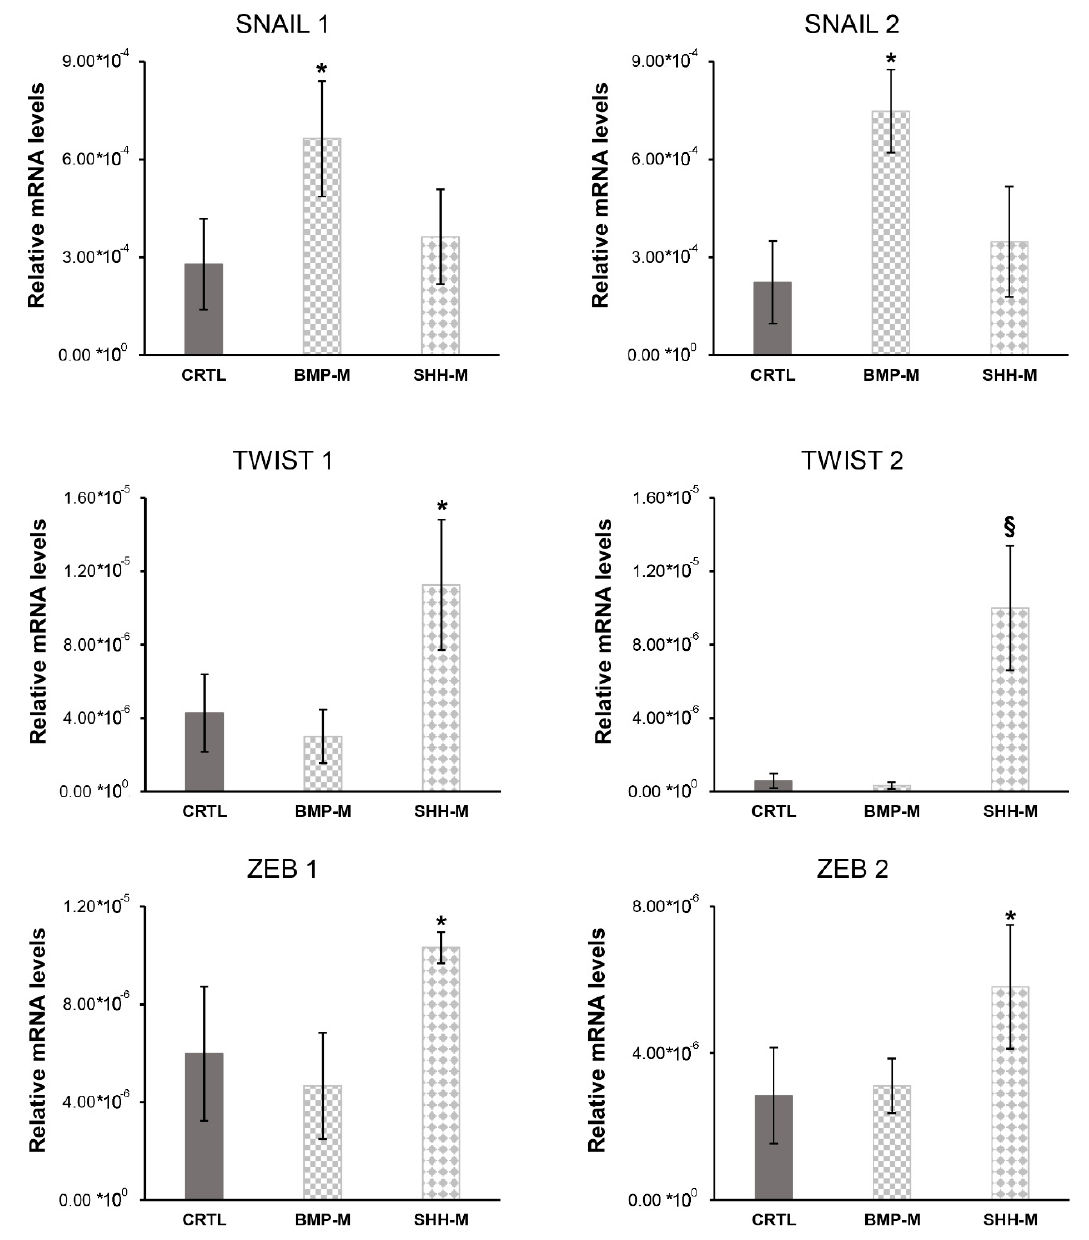
Figure 7. BMP-4 and SHH protein activation pathways induced the expression of EMT markers. Relative gene expression of EMT markers TWIST1 , TWIST2 , SNAIL1 , SNAIL2 , ZEB1 , and ZEB2 ) measured by RT-qPCR of hBTSCs cultured in basal condition (KM), BMP-M or SHH-M. Data expressed as mean ± SD of N = 6 experiments; * p < 0.05; § p < 0.01.